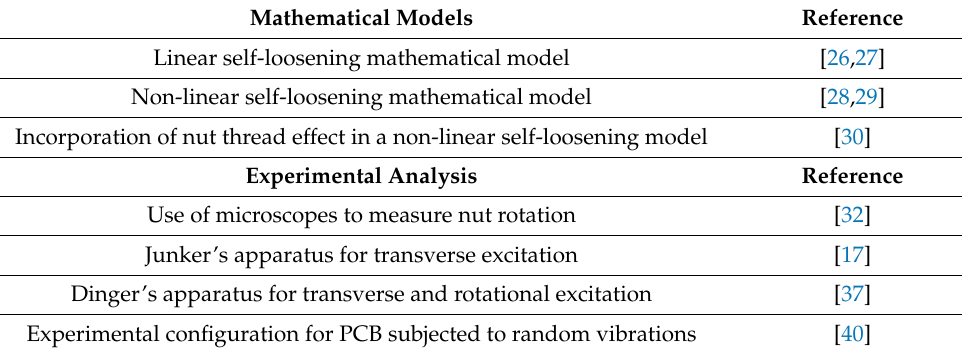
Table 3 enlists the various mathematical models as well as experimental techniques used to investigate the self-loosening phenomenon. Table 3. Review of literature on self-loosening due to vibrational